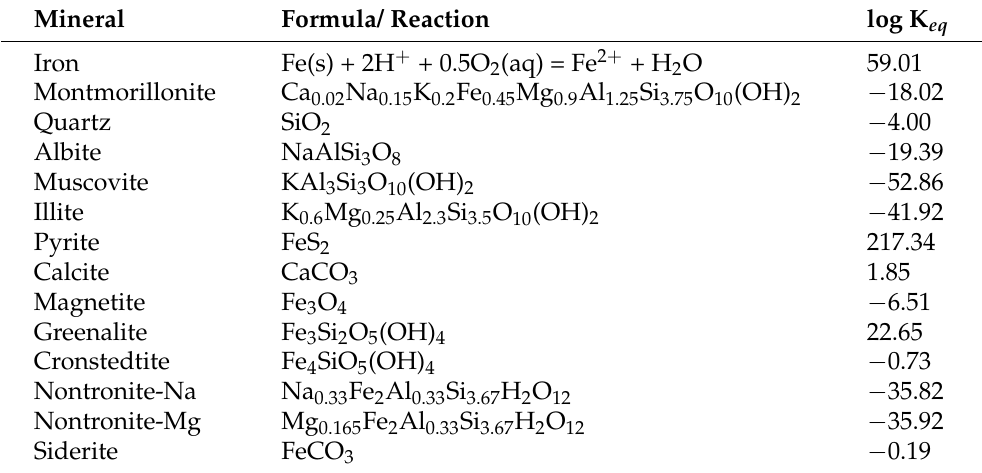
Table 4. Equilibrium constants (log K eq at 25 ◦ C) of the minerals taken into account in the numerical model. Reactions are written as the dissolution of 1 mol of mineral in terms of the primary